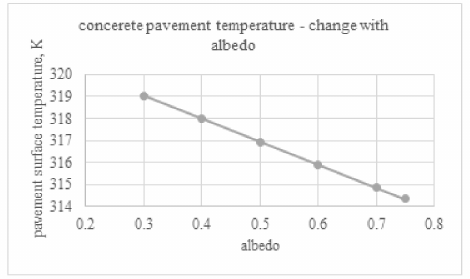
Figure 9. Concrete pavement top surface temperatures with changing albedo